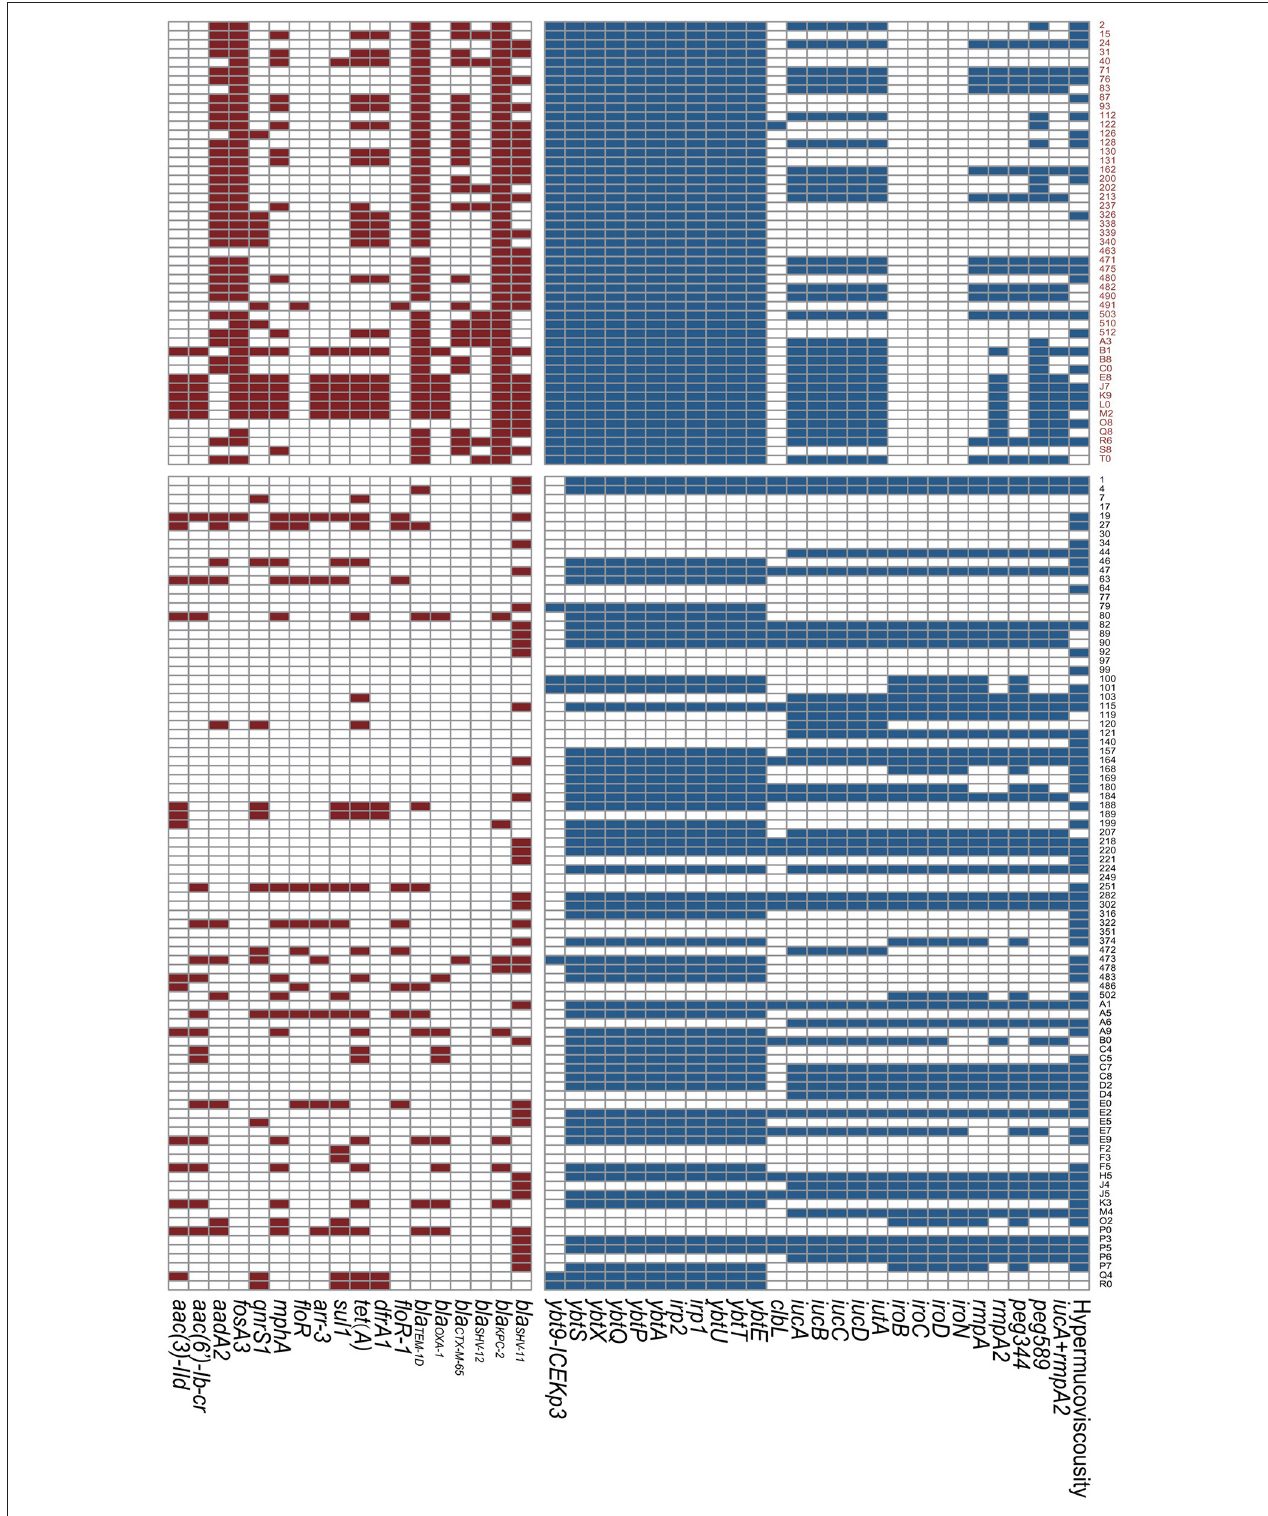
FIGURE 1 | Resistance genes and virulence genes of Klebsiella pneumoniae strains. The colored blocks represent existence of genes. Red, ST11 group; Black, Non-ST11 group.